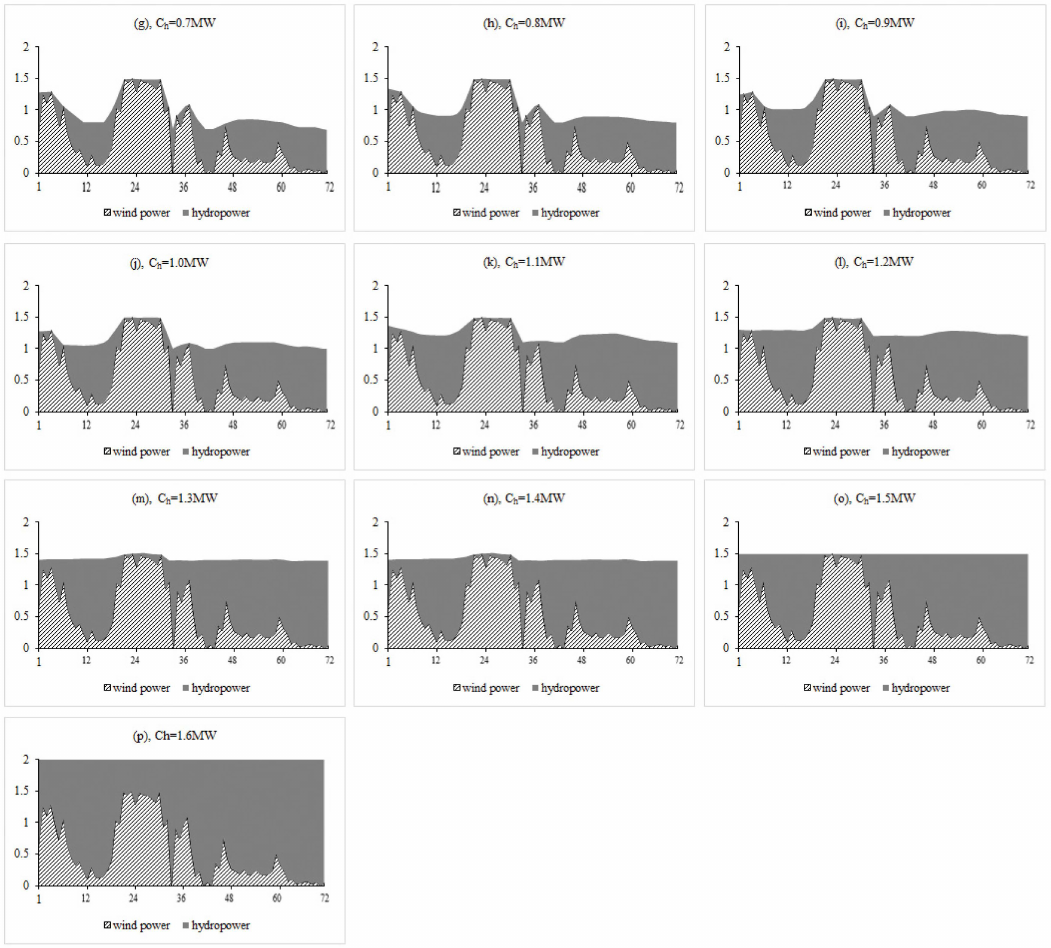
Figure 14. Combined output with different hydropower capacities in flood season. ( a ) the combined output with hydropower capacities of 0.1 MW; ( b ) the combined output with hydropower capacities of 0.2 MW; . . . ; ( p ) the combined output with hydropower capacities of 1.6